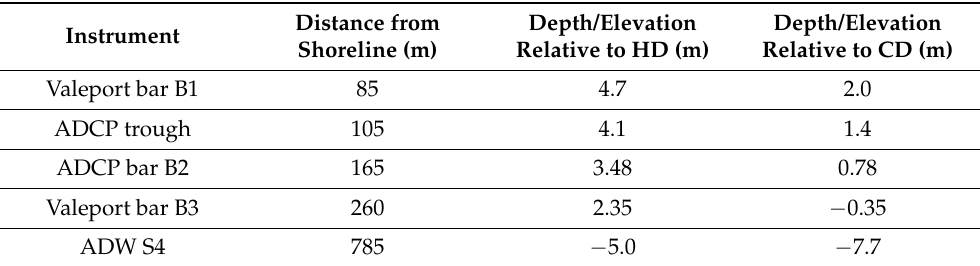
Table 1. Distance from shoreline and depth/elevation of hydrographic instruments relative to Hydrographic Datum (HD) and Chart Datum (CD). Distance was measured from the toe of foredune in the backshore, considered as the position of shoreline. Distance from Depth/Elevation Depth/Elevation Instrument Shoreline (m) Relative to HD (m) Relative to CD (m) Valeport bar B1 85 ADCP trough 105 ADCP bar B2 Valeport bar